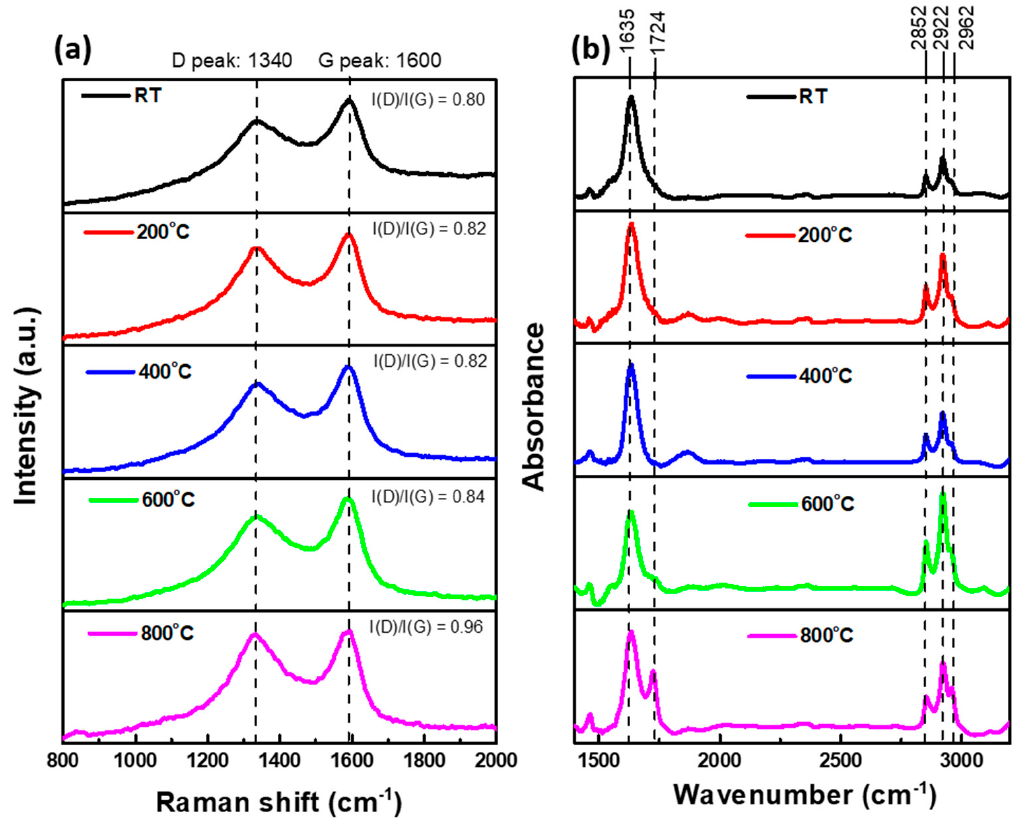
Figure 5. ( a ) Raman and ( b ) FTIR spectra obtained for five aBC samples generated at specific treatment temperatures.